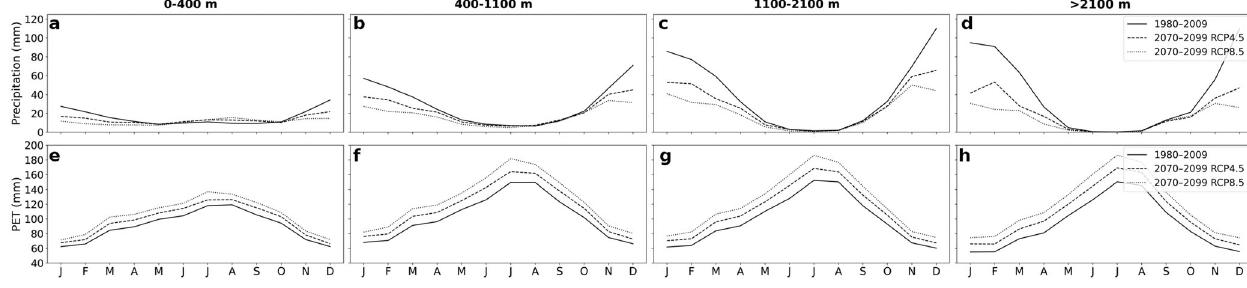
Fig. 4 Annual precipitation and evapotranspiration cycle for recent past and future projections by altitude levels. a – d Annual cycle in precipitation (mm) and e – h potential evapotranspiration (PET mm), for 30-year period simulations: recent past (1980 – 2009) and future (2070 – 2099), scenarios RCP4.5 and 8.5, at the four altitude intervals analyzed.